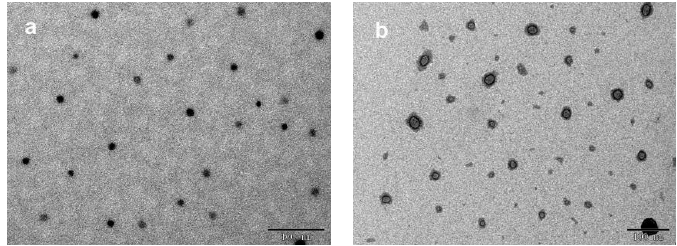
Figure 4. Transmission electron microscope (TEM) images of FCNs in the absence of metronidazole (MNZ) ( a ) and presence of MNZ ( b ).